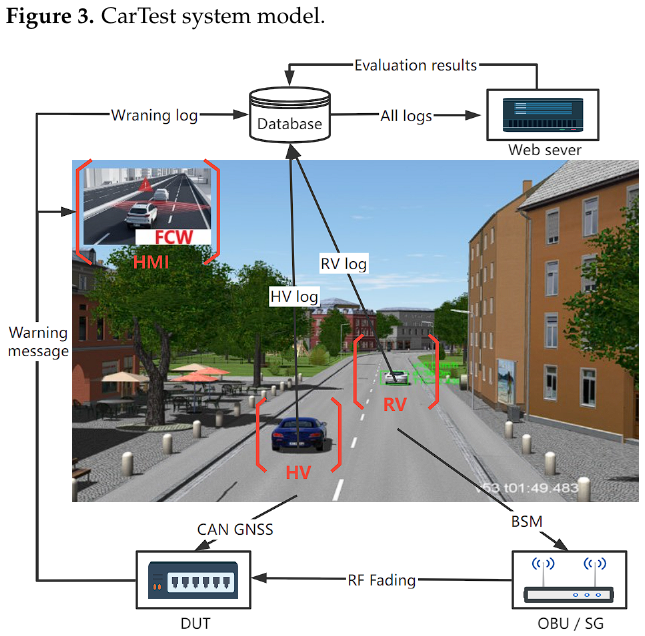
Figure 4. CarTest data flow chart.